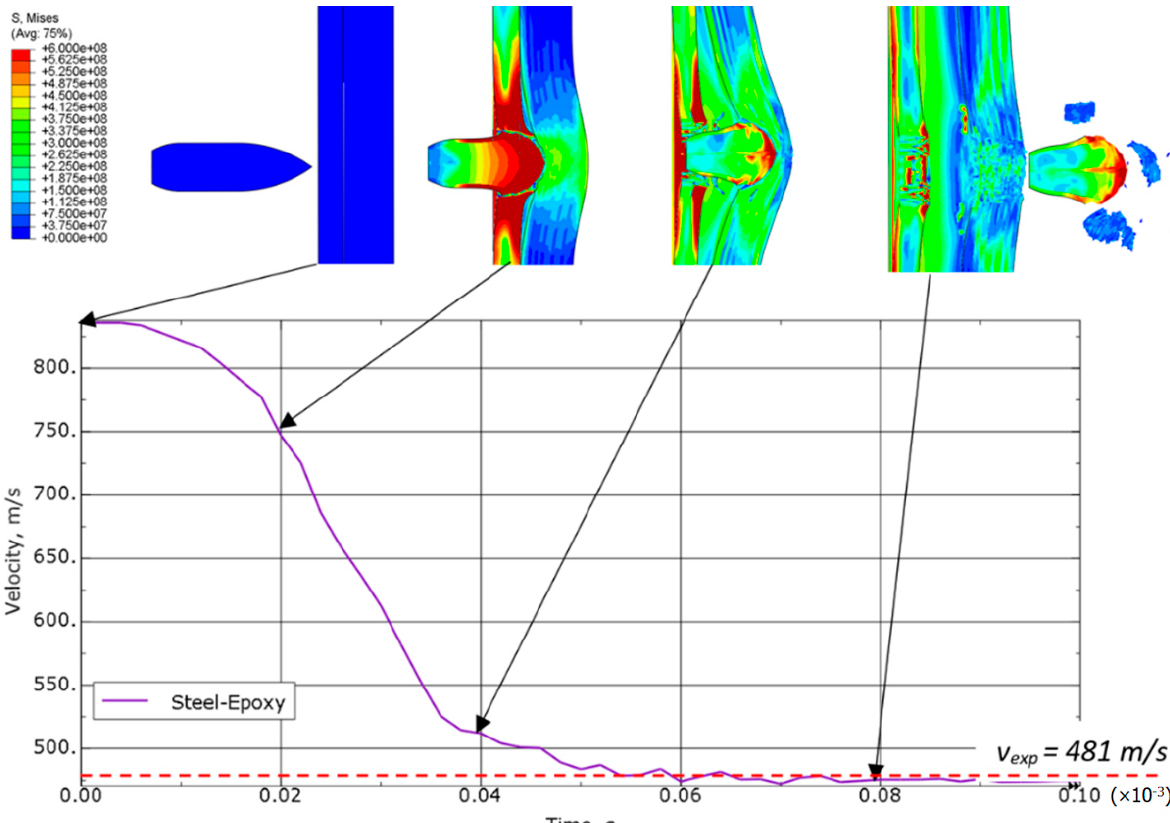
Figure 8. Equivalent von Mises stress distribution (in Pa) and speed drop for a steel-laminate